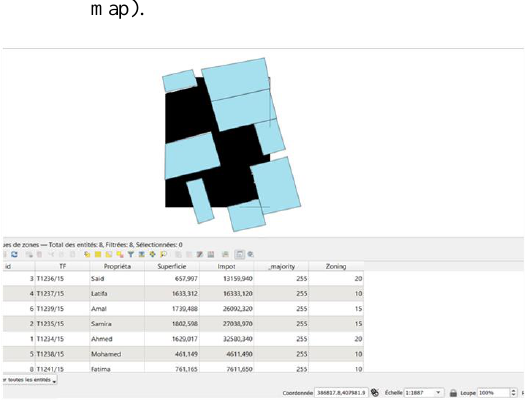
Figure 16 . Result of the tax-oriented GIS